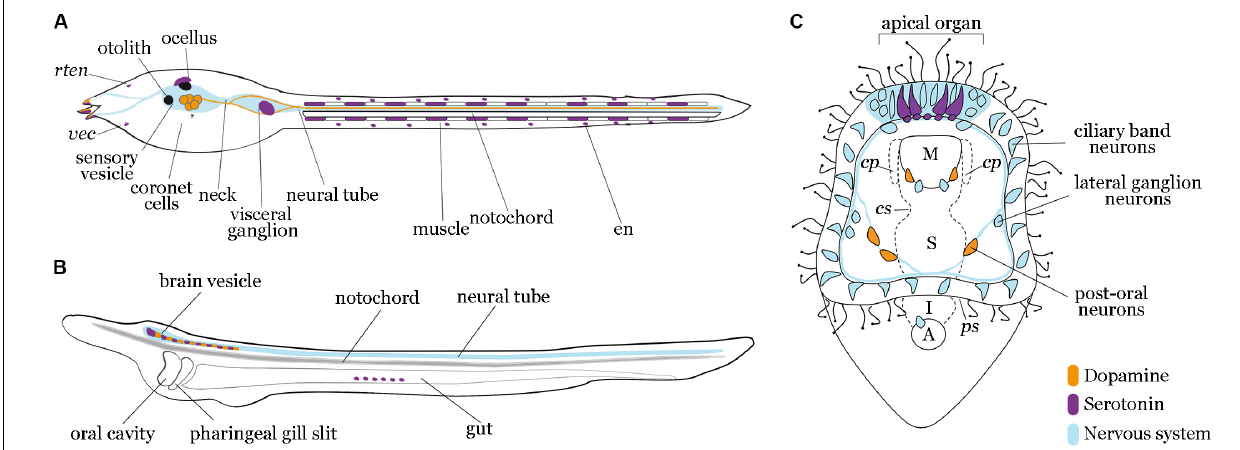
FIGURE 1 | Localization of dopamine and serotonin expressing cells in tunicates, cephalochordates and echinoderms. Diagrams of tunicate (A) , lancelet (B) , and sea urchin (C) larvae depict dopaminergic (orange) and serotonergic (purple) neurons relative to nervous system (light blue). (A) Tunicate tadpole larva model showing signals reported in C. robusta and P. mammillata , with asterisks highlighting conserved dopaminergic neurons in both species. Dopamine is present in the coronet cells of the sensory vesicle in both species. Moreover, in P. mammillata, dopamine has been shown in the adhesive papillae, in the whole dorsal neural tube and in some fibers of the visceral ganglion extending to the tail. Serotonin is present in the visceral ganglion and muscle cells along the tail in C. robusta , while in P. mammillata it occurs in the sensory vesicle, adhesive papillae, visceral ganglion and epidermal neuron. rten, rostral trunk epidermal neuron; vec, ventral endodermal cell; en, epidermal neuron. (B) Lancelet larva model showing signals reported in B. lanceolatum and B. floridae . Dopaminergic and serotonergic neurons have been described for both species in the cerebral vesicle and the anterior part of the nerve cord. Additionally, in B. floridae serotonin has been observed in frontal eye and gut epithelium. (C) Sea urchin early pluteus larva model ( S. purpuratus ) showing serotonergic neurons localized in the most anterior part of the nervous system, the apical organ domain; two dopaminergic neurons are localized in the lower lip near the esophageal domain and three dopaminergic neurons approach the post-oral arms of the larva. M, mouth; cp, coelomic pouches; cs, cardiac sphincter; S, stomach; ps: pyloric sphincter; I, intestine; A,